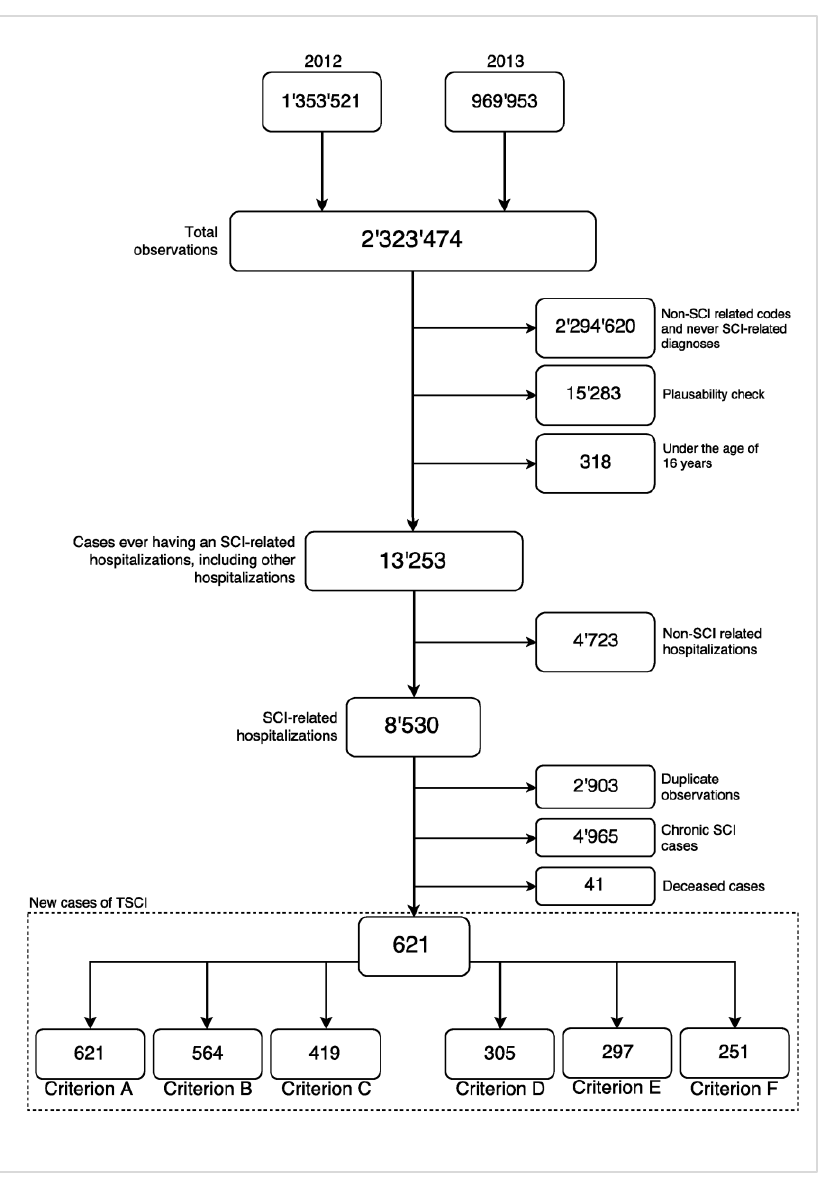
Figure 1: Selection criterion of ICD-10 diagnosis